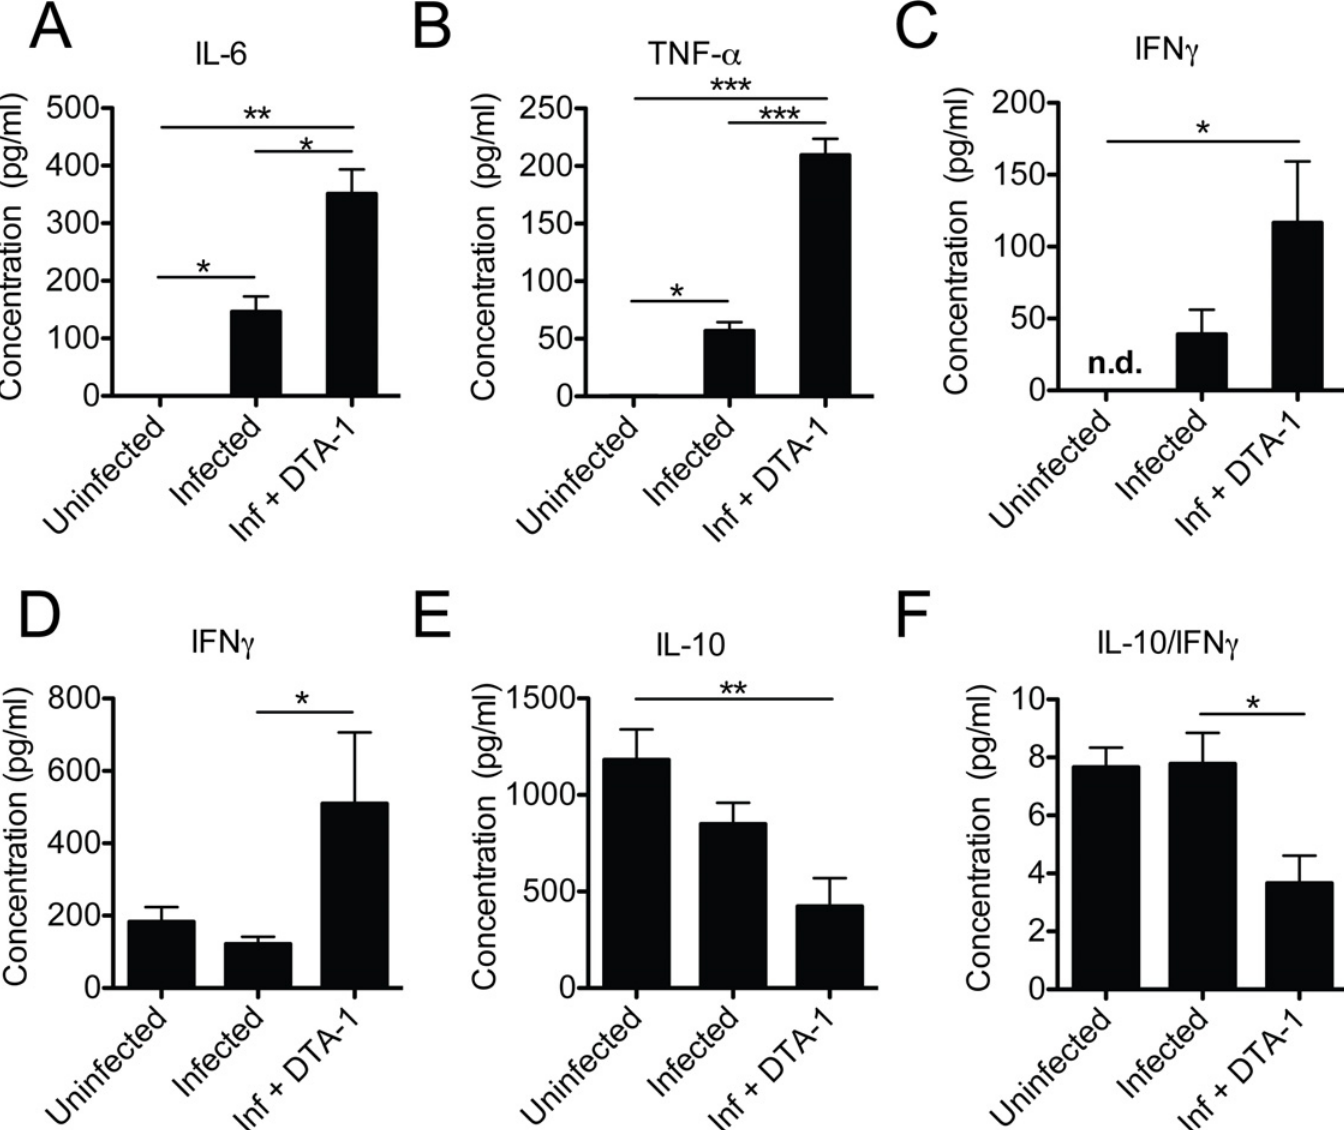
Fig 3. Cytokine production is largely altered by DTA-1 in response to T . gondii infection in vivo . (A, B and C) C57BL/6 mice were treated or not with 500 μ g of DTA-1 one day before experimental infection. In the control group PBS was administered. Infection was performed with 20 cysts injected i.p. Five days later mice were euthanized and the peritoneal fluid was collected and promptly analyzed by CBA. (D) C57BL/6 mice infected with ME-49 submitted or not to a single dose treatment with DTA-1 were sacrificed five days after infection and had their lungs collected for the cytokine expression analysis by ELISA. Results were expressed as mean +/- SEM. * P < 0.05, ** P < 0.01 and *** P < 0.001 (n =